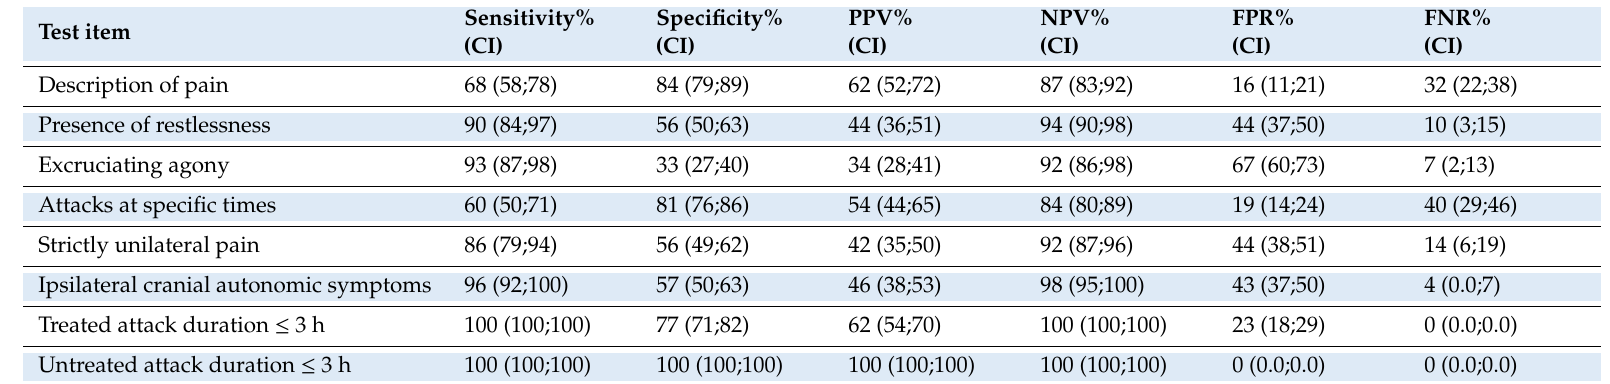
Table 4. Sensitivity and specificity statistics for items with dichotomous